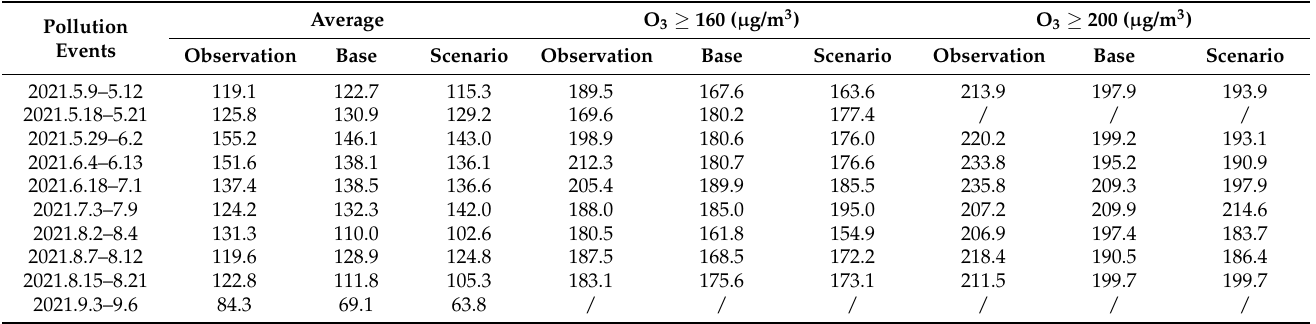
Table 5. Comparisons of O 3 concentrations between the baseline and scenario simulations by reducing the Mount Tai terrain heights for ten O 3 pollution events in 2021 in Tai’an ( µ g/m 3 ).